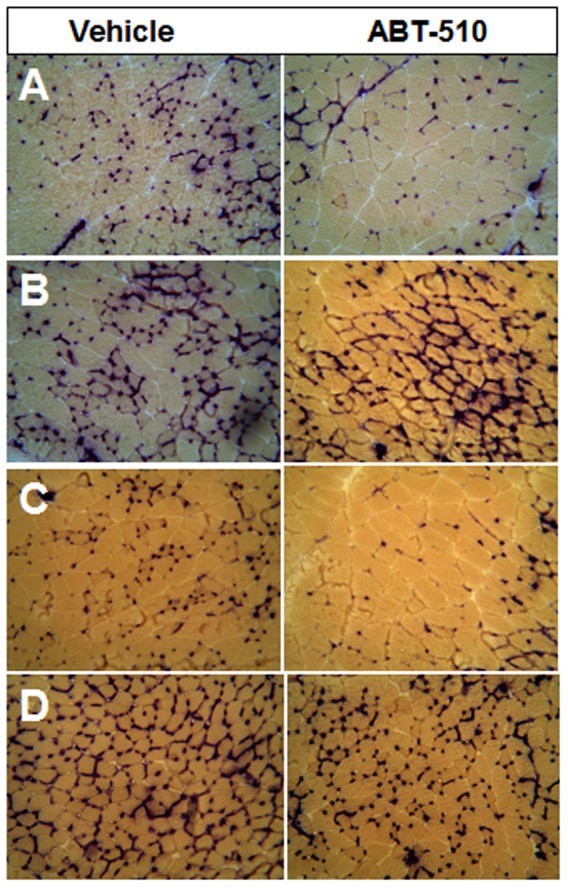
Representative figures of the histology sections.A) Superficial Gastrocnemius Muscle B) Deep Gastrocnemius Muscle C) Plantaris Muscle, D) Soleus Muscle.